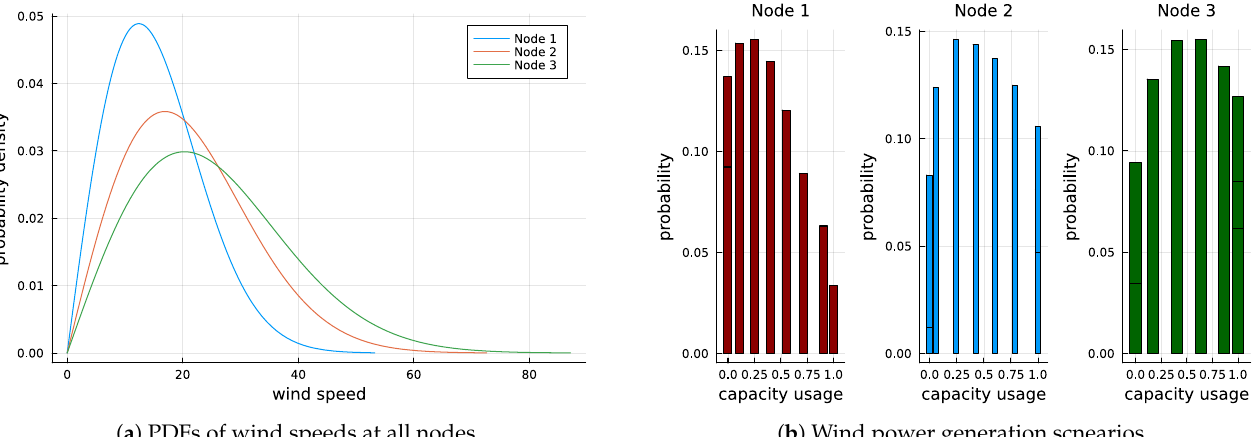
Figure 3. The probability density functions of wind speeds in Mph at each node are shown in ( a ); ( b ) shows the resulting scenarios, denoting the proportion of rated power W ω , o , n and their respective